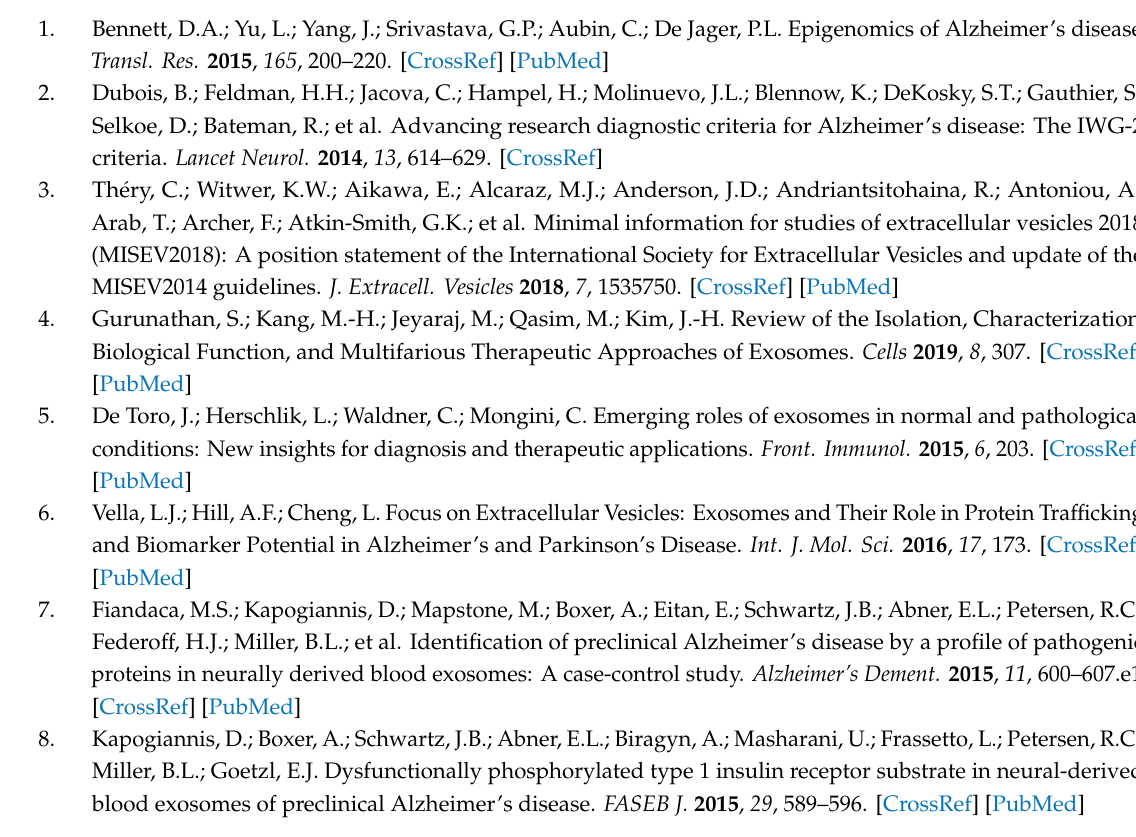
Supplementary Table S1: table with age distribution and known biomarkers for all participants. Supplementary Table S2: list of miRNAs detected in both subpopulations of EVs by using TaqMan OpenArray ® miRNA panel. Supplementary Figure S1: representative outcome of NTA on small NDEVs suspension and its negative control is reported; Supplementary Figure S2: representative Agilent 2100 Bioanalyzer results of EV derived